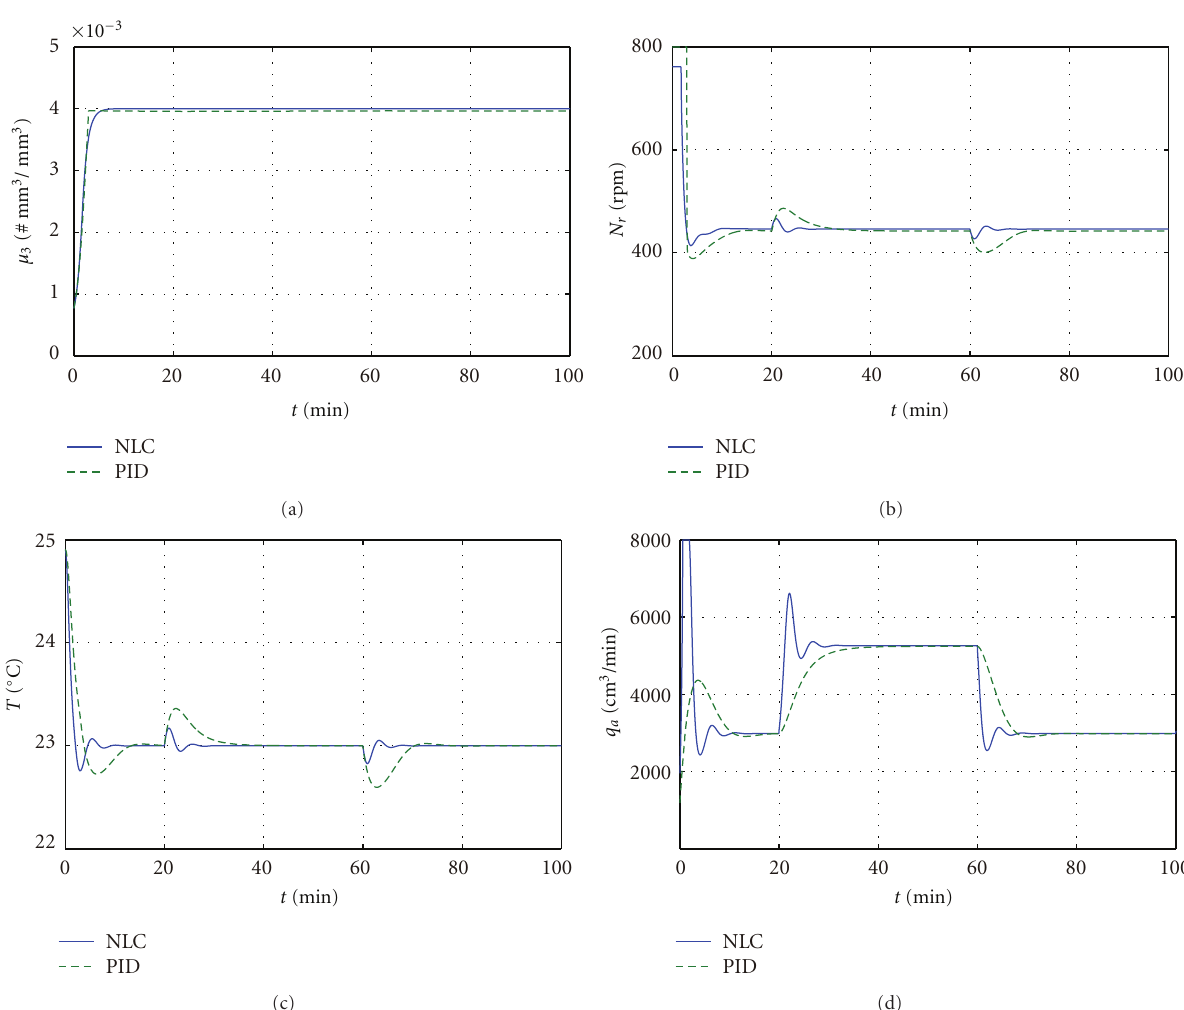
Figure 6: Closed-loop dynamic responses for the MIMO system when a disturbance change of ± 1 ◦ C were used in the feed